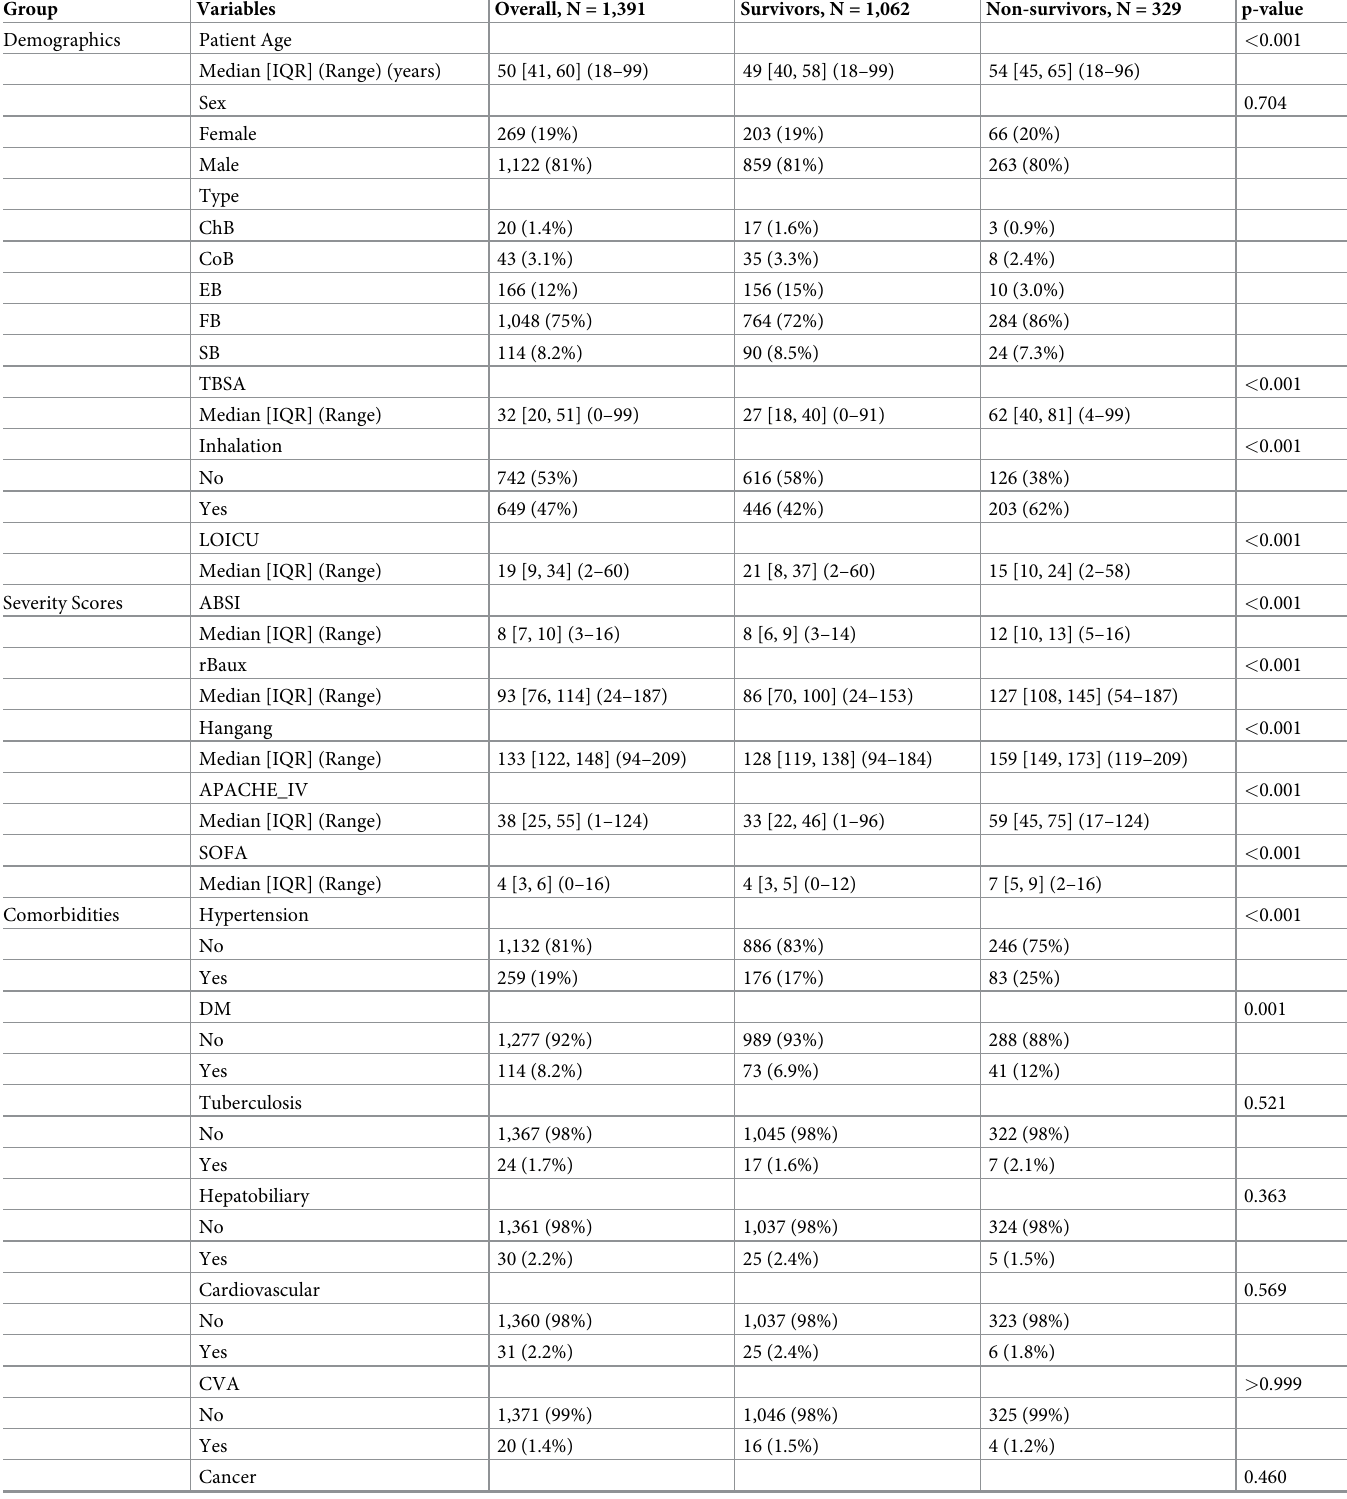
Table 2. Demographic and infection sources according to 60-day